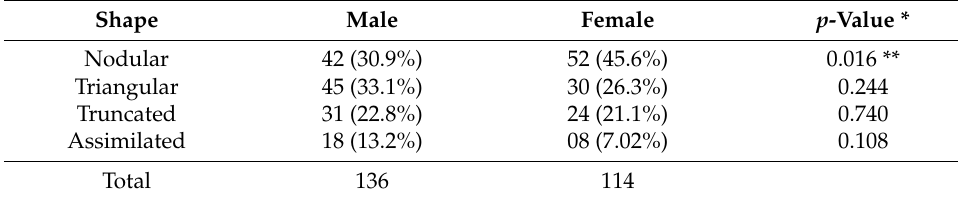
Table 2. Variations in shapes of the lingula between the genders ( n = 250 sides).